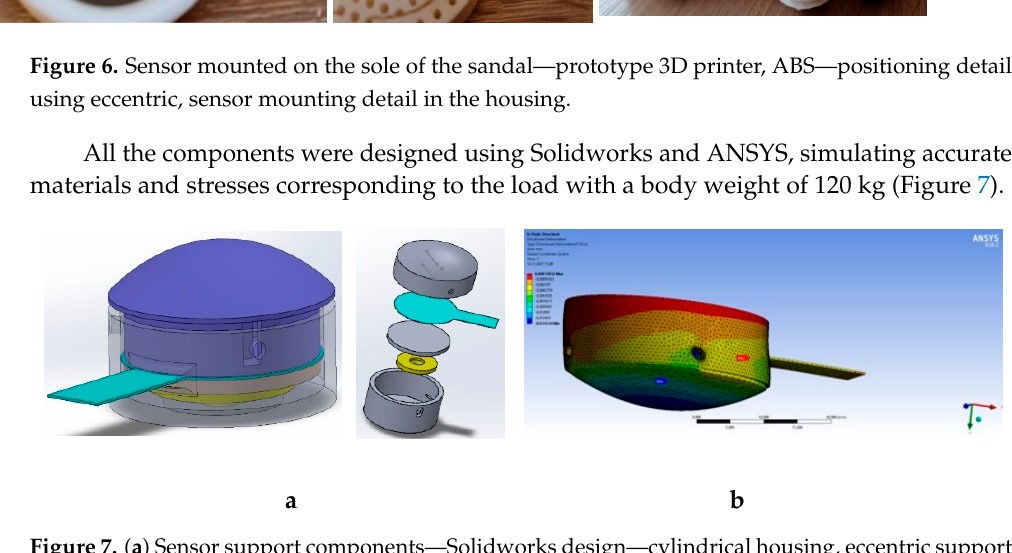
Figure 7. ( a ) Sensor support components—Solidworks design—cylindrical housing, eccentric support mounting, sensor support base, pressure sensor, ground contact cylinder (finished with spherical part); ( b ) Sensor simulation details using ANSYS.